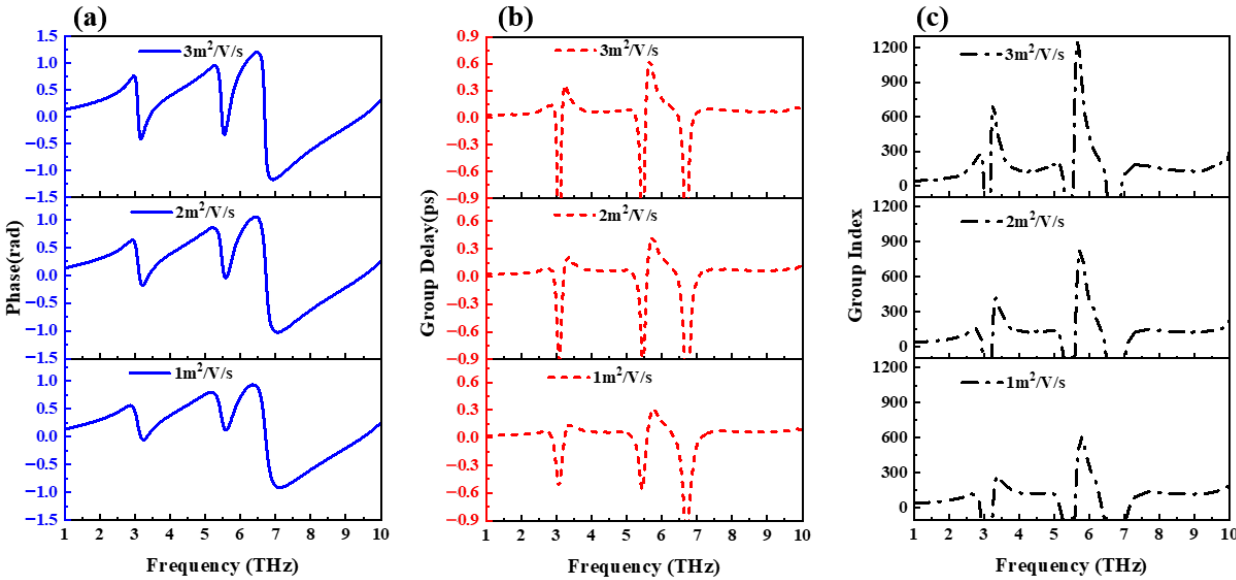
Figure 8. Influence of graphene’s carrier mobility on structural slow-light effect. ( a ) Effect on phase. ( b ) Effect on group delay. ( c ) Effect on group index.